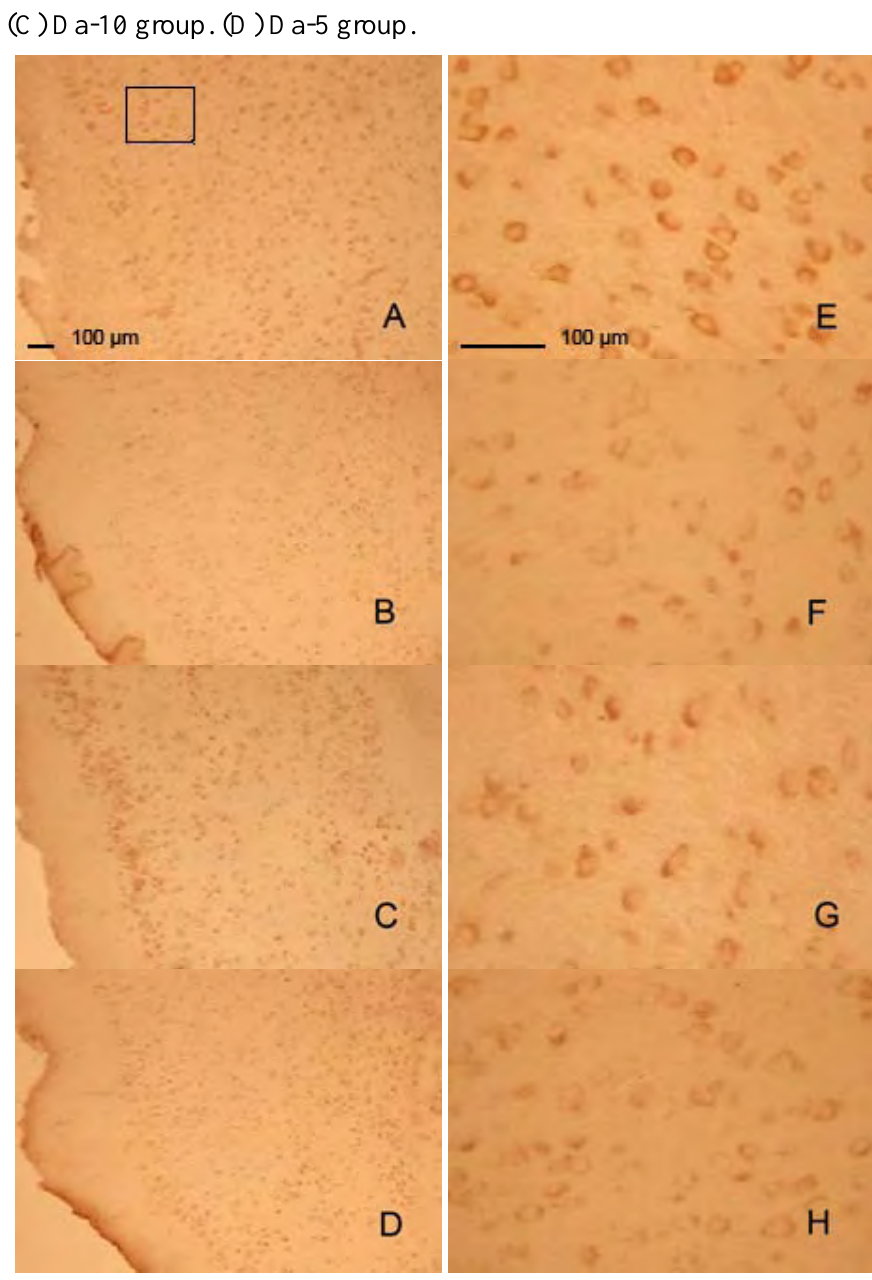
Figure 7 . Effects of daidzein on the expression levels of caspase-3 in D-gal-treated mice cortexes. (A) Aging control. (B) Vehicle control. (C) Da-10 group. (D) Da-5